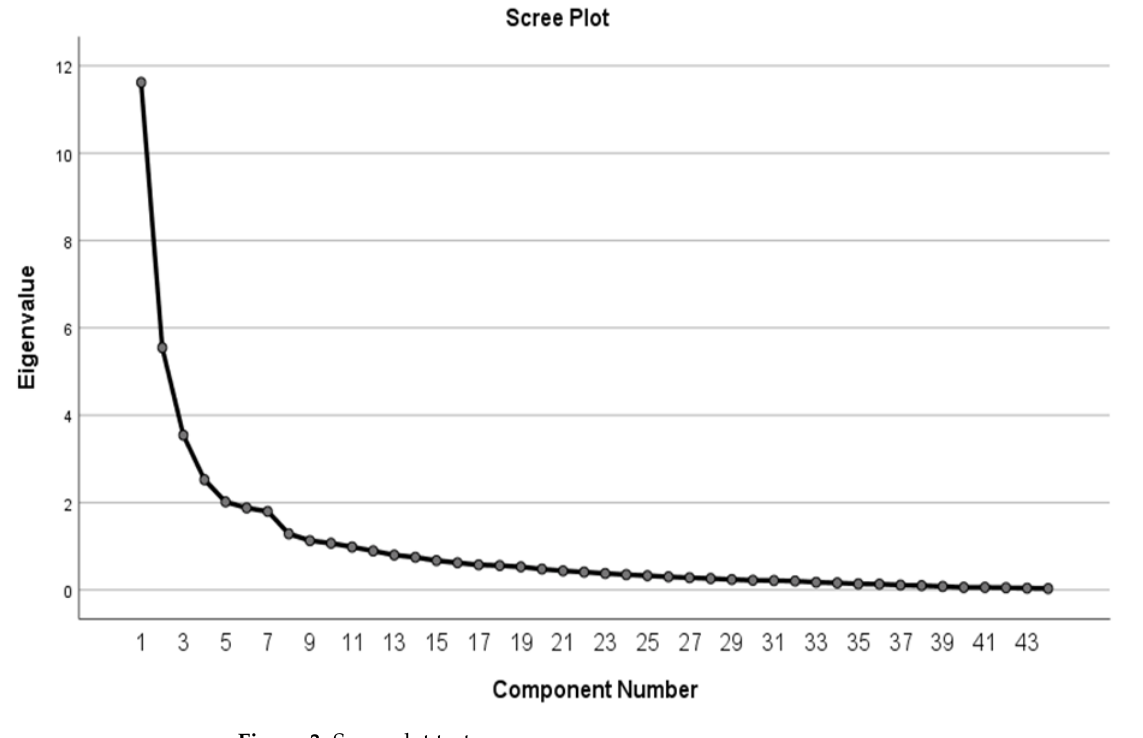
Figure 3. Scree plot test. Table 5. Reliability of